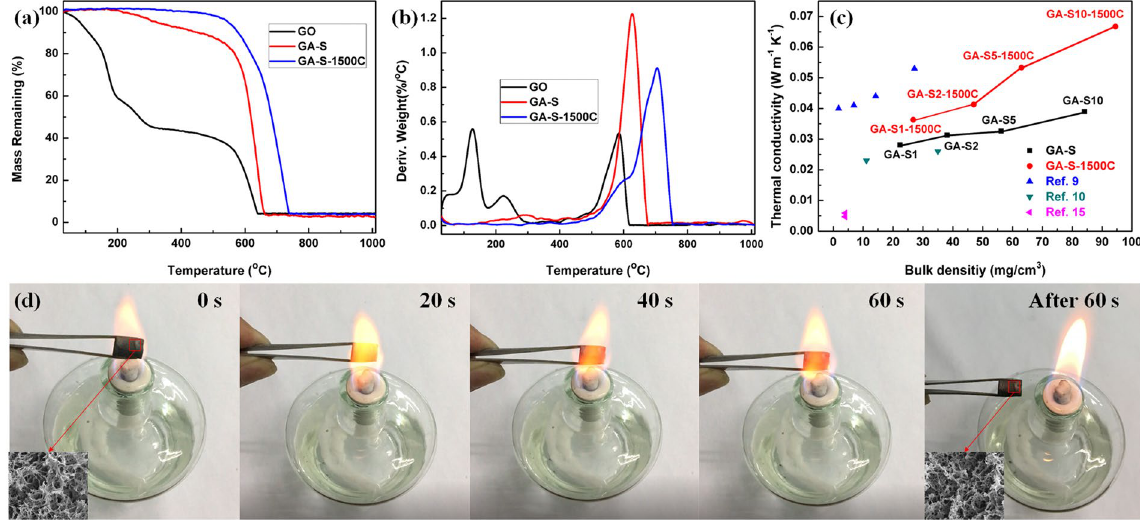
Figure 7. TG ( a ) and DTG ( b ) plots of GO, GA-S and GA-S-1500C in air. ( c ) Thermal conductivities of GA-S, GA-S-1500C and other low thermal conductive graphene aerogels. ( d ) Snapshots of GA-S-1500C sample in a hot flame of an alcohol burner, the insets in ( d ) were the microstructure of tested sample.